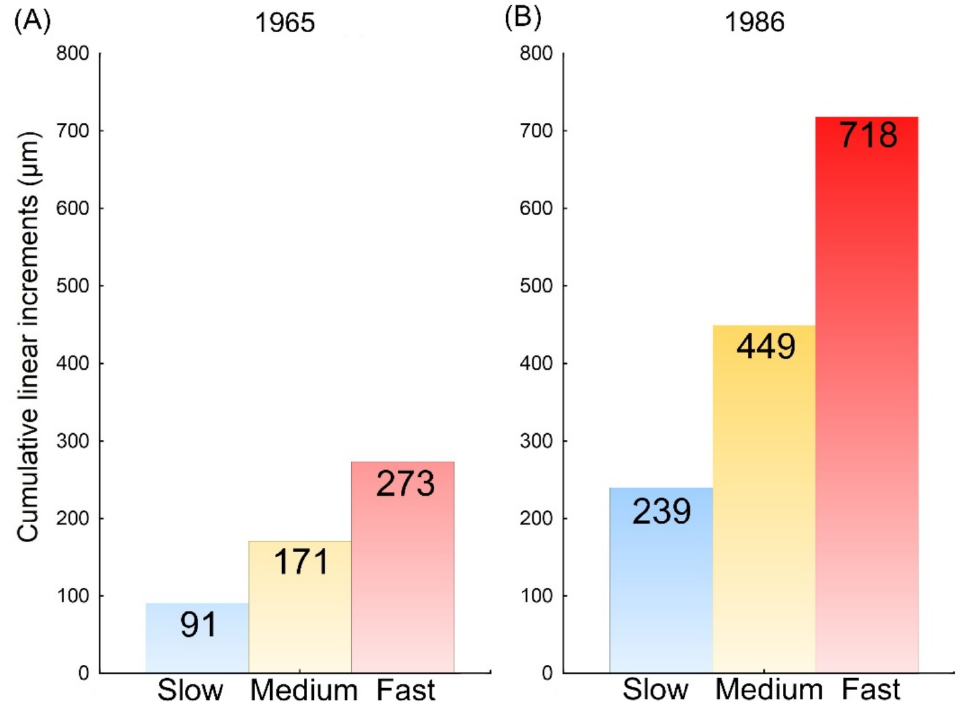
Figure 6. Schemes follow the same formatting. Simulated cumulative production of cambium (or TRW) obtained for slow- (blue bar), medium- (yellow bar) and fast-growing (red bar) trees over the growing seasons of dry 1965 ( A ) and moist 1986 ( B